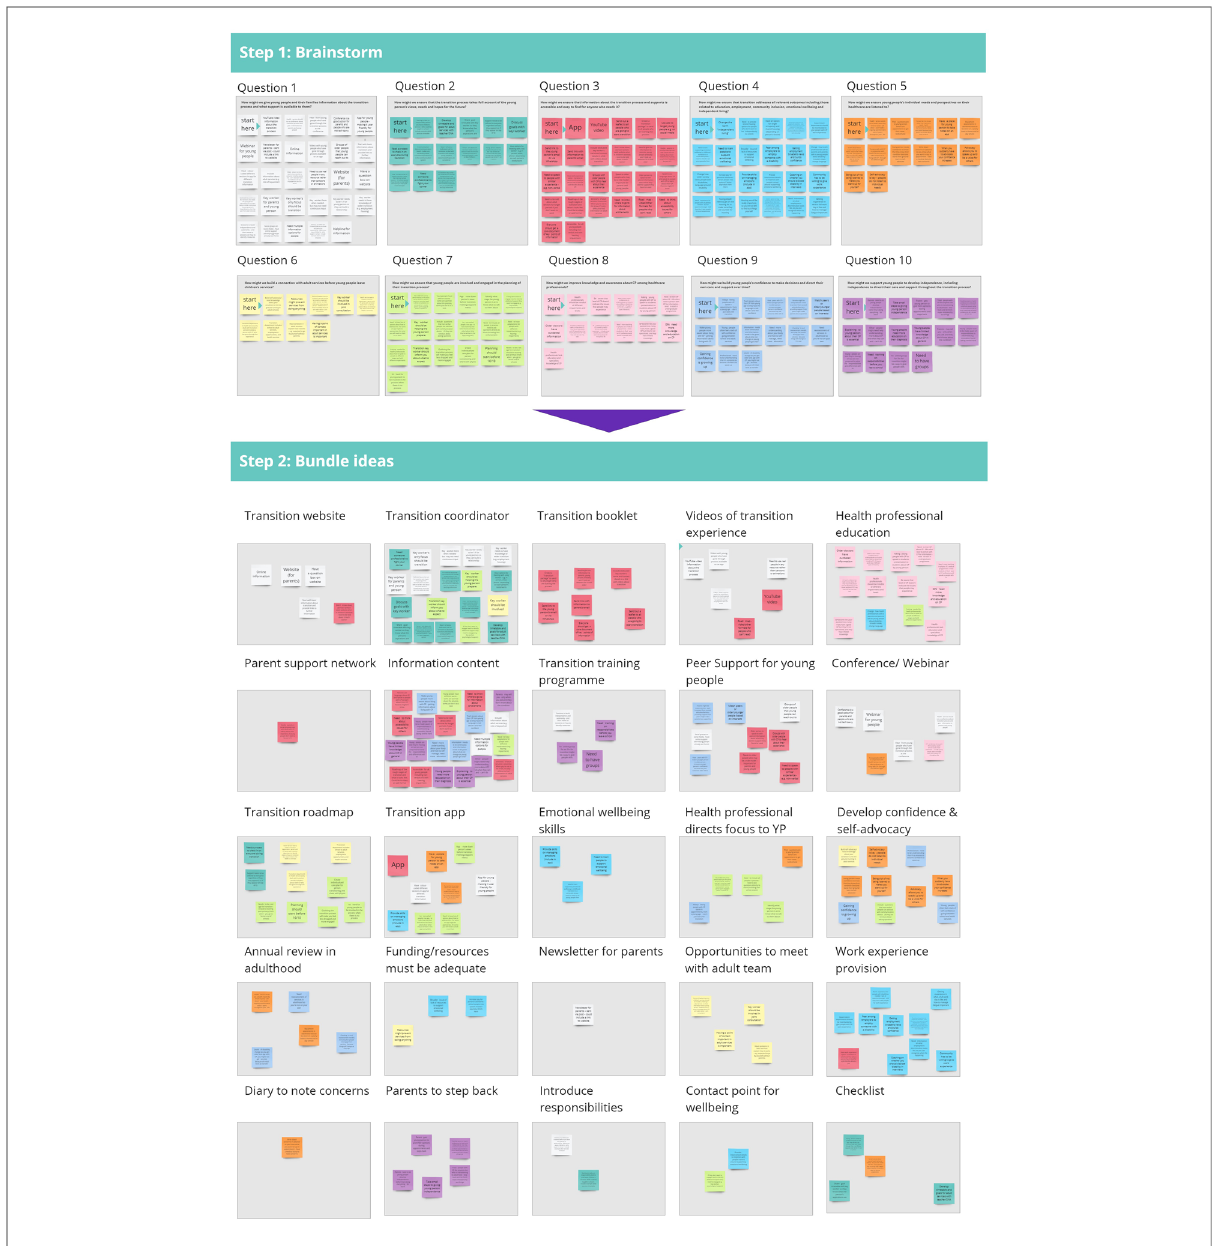
FIGURE 2 Brainstorm and bundle activities completed in workshop